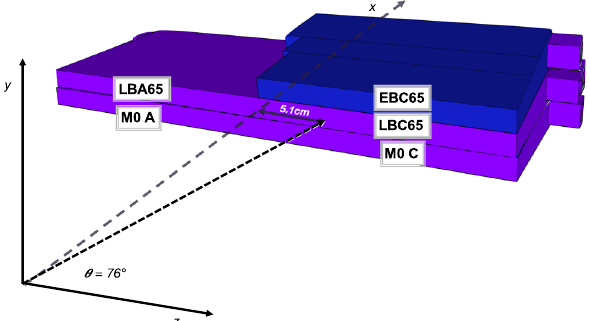
Fig. 2 Schematic view of the TileCal modules as stacked on the scan- ning table at the H8 beam line. The names of the super-drawers and the direction and the interaction point of the particle beams in the detector are shown